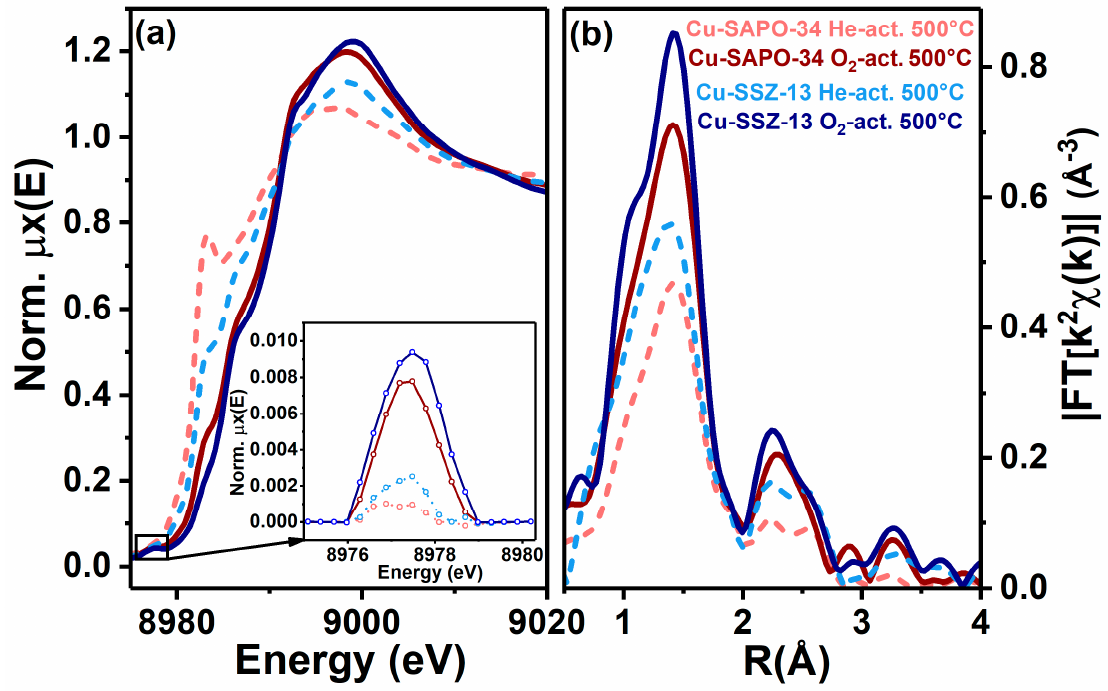
Figure 7. XANES ( a ) and FT-EXAFS ( b ) spectra of 0.25CuSAPO-34 (red) and 0.50CuSSZ-13 (blue) after He-activation at 500 ◦ C (light coloured, dotted lines) and after consecutive O 2 -activation for 1 h (dark coloured, solid lines). The inset in ( a ) is an enhancement of the dipole-forbidden 1s → 3d transition in the pre-edge region.